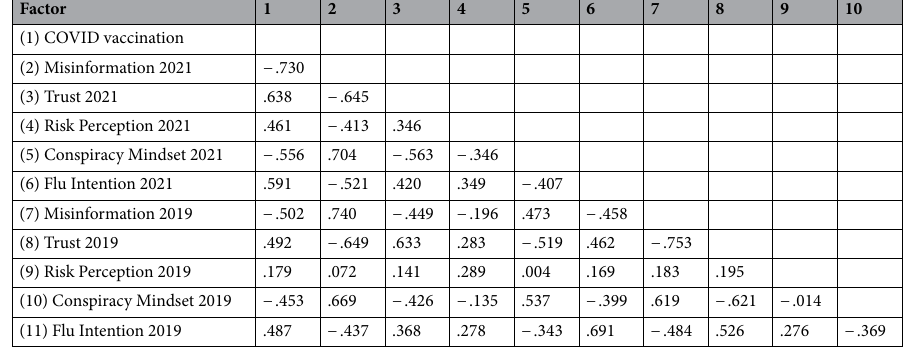
Table 6. Table of intercorrelations between current and lagged predictors of COVID vaccination intention based on the measurement model.